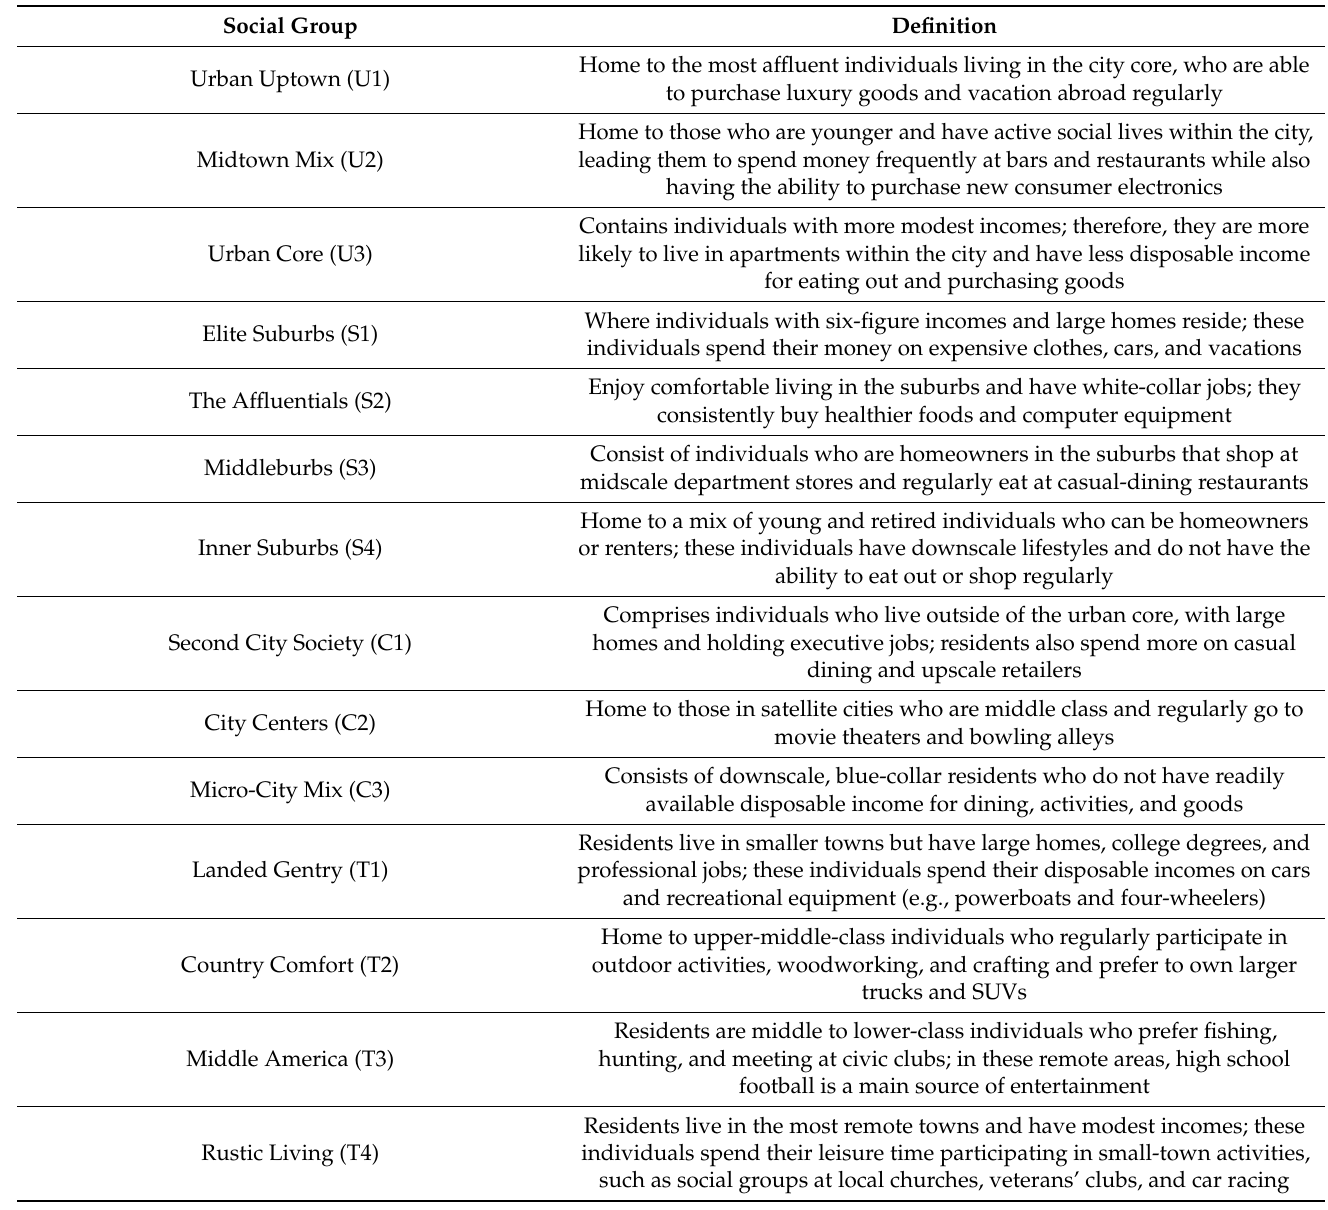
Table 2. Claritas PRIZM Premier Social Group